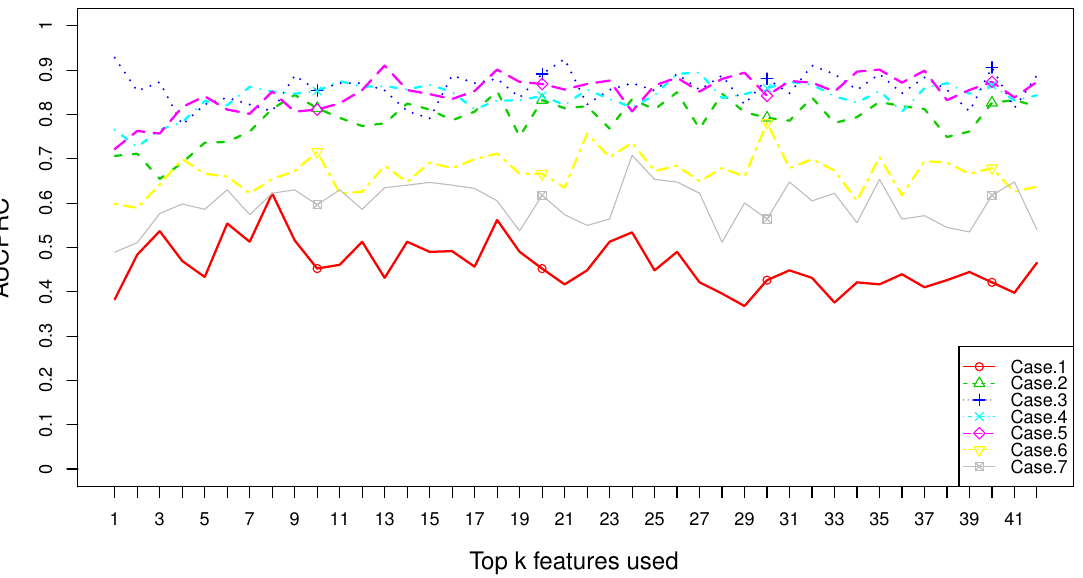
Figure 7. AUCPRC when top k features are used with the dataset “TBI” on seven cases.